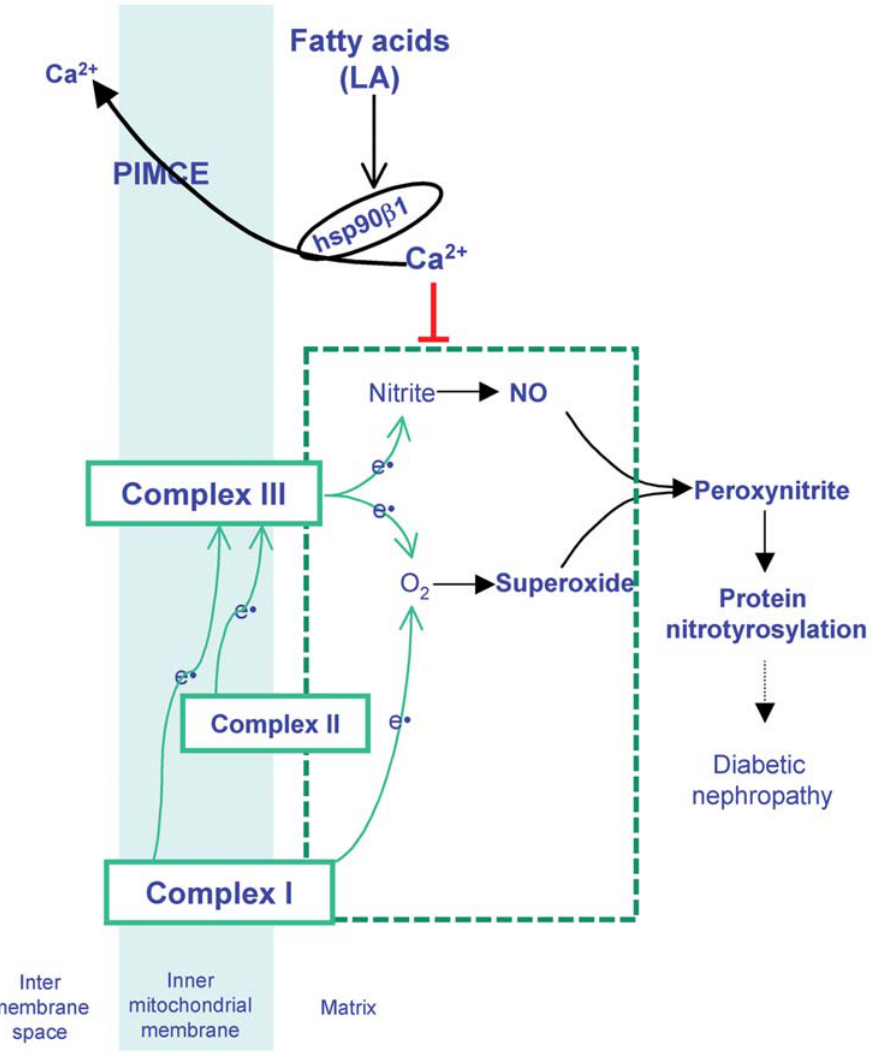
Figure 8. Mechanism of excessive NEFA contributing to pathogenesis of diabetic nephropathy. NEFA, such as linoleic acid (LA, an 18:2 n- 6 polyunsaturated fatty acid) induces Ca 2 + efflux from mitochondria by activating a hsp90 b 1-dependent pathway (PIMCE). The LA responsive mitochondrial Ca 2 + efflux diminishes the inhibitory effect of Ca 2 + on superoxide production from complexes I or III and enhances nitrite conversion to NO by complex III, resulting in increased peroxynitrite formation and protein nitrotyrosylation. Protein nitrotyrosylation may disrupt the normal functions of mesangial cells and the kidney, leading to abnormalities in the structure and/or function of diabetic kidney.